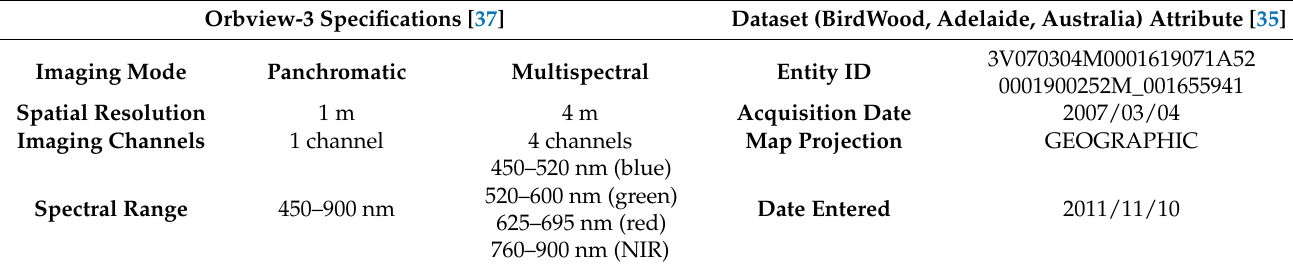
Table 2. Orbview-3 Specifications and GeoEye’s OrbView-3 satellite Dataset